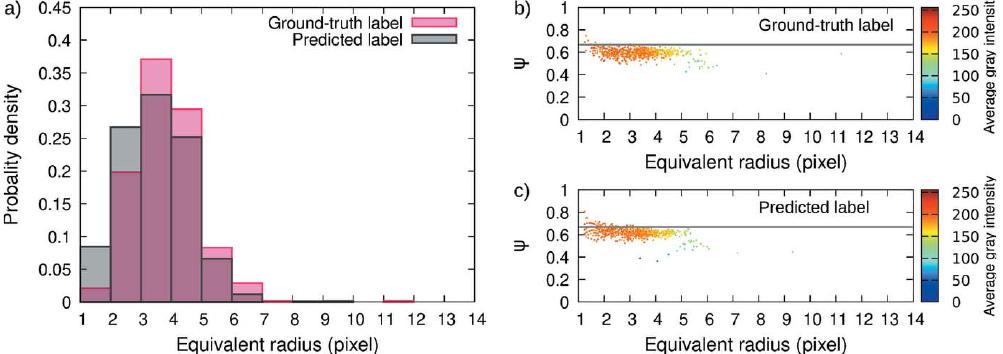
Figure 6 ( a ) Histogram of the object size distribution from ground-truth data and predicted data. ( b and c ) The sphericity ( ) parameter as a function of radius for the ground-truth and predicted data, respectively, for the test set. Color scales in ( b ) and ( c ) represent the average gray intensity value of the objects. The gray line at = 2/3 is the parameter for a sphere discretized by voxels without surface reconstruction.